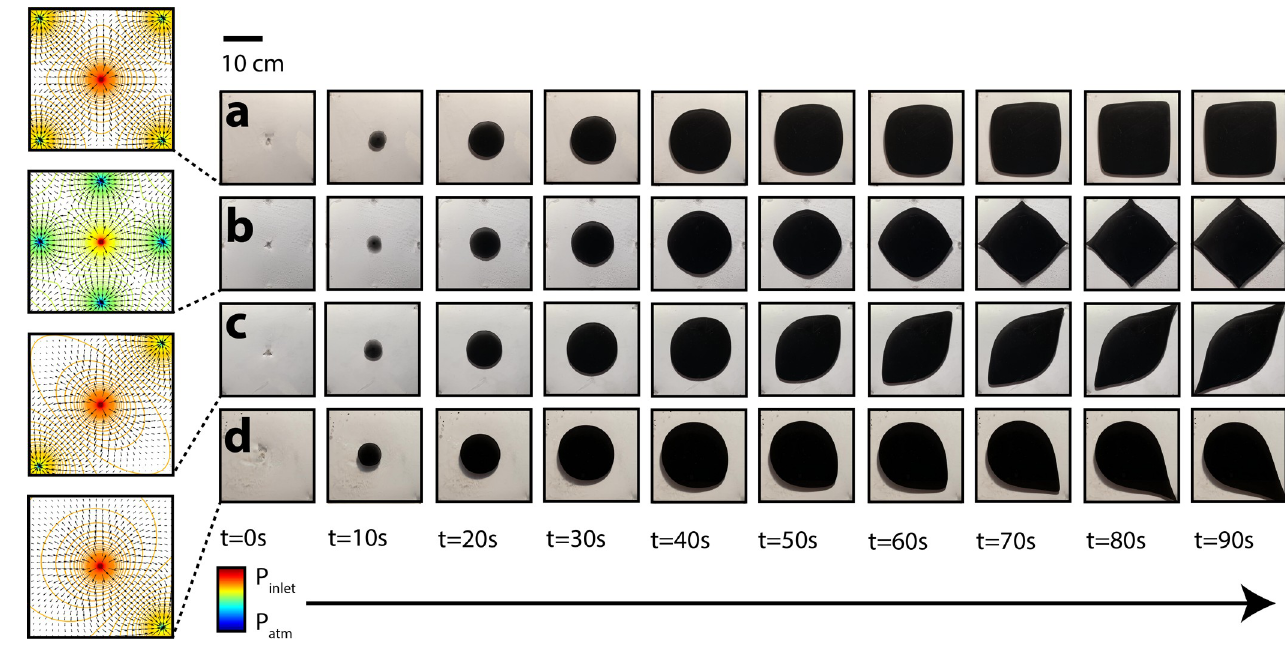
Fig 4. Time-dependent droplet growth under four unique potential flow fields